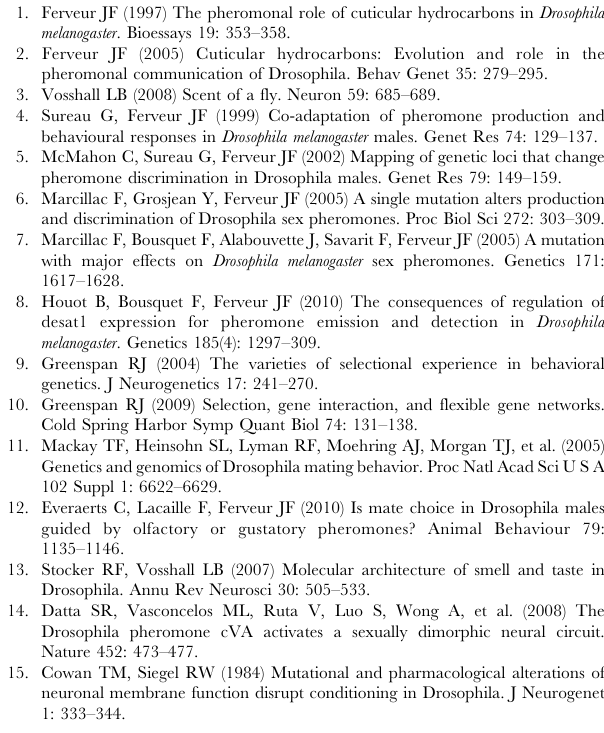
Table S2 Transcriptional variation of genes in lines selected for high/low discrimination in two genetic backgrounds. The genes listed in the left column, initially detected by microarrays in the desat1 mutant background, were retained on the basis of high P-value in RNA extracted from the head vs. RNA extracted from the rest of the body. The variation of their transcriptional activity (x= increase; : = decrease) was measured by q-PCR in the desat1 (left) and wild-type (right) genetic backgrounds in males of the High and Low selected lines, relative to the level found in unselected lines of respective background. The levels were transformed on a log scale and the probability (P) of a significant variation indicated (ns =non significant). Table S3 Original microarray data. Raw data for results in Table S2, from Affymetrix Drosophila 2.0 arrays on labeled RNA extracts from heads (He) and bodies (Bo) from unselected (Un), high (Hi) and low (Lo) lines. Each value is marked as ‘‘Present’’ (P) or ‘‘Absent’’ (A) based on Affymetrix’ standard ‘‘detection above background’’ software analysis (http://media.affymetrix.